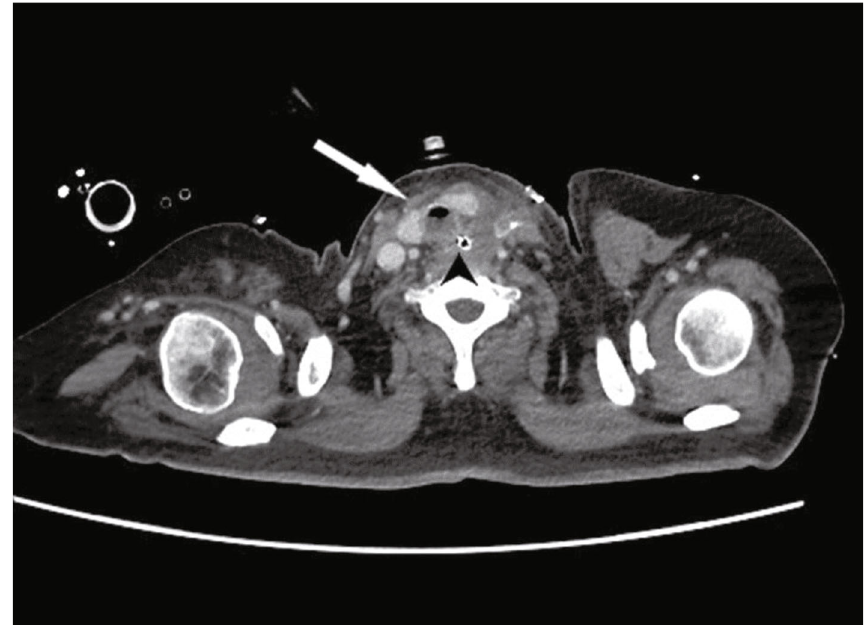
Figure 3: Postoperative neck CT. A neck CT obtained on postoperative day 10 shows no free air between the trachea (arrow) and the esophagus (arrowhead) at the level of the tracheoesophageal fi stula repair (above the